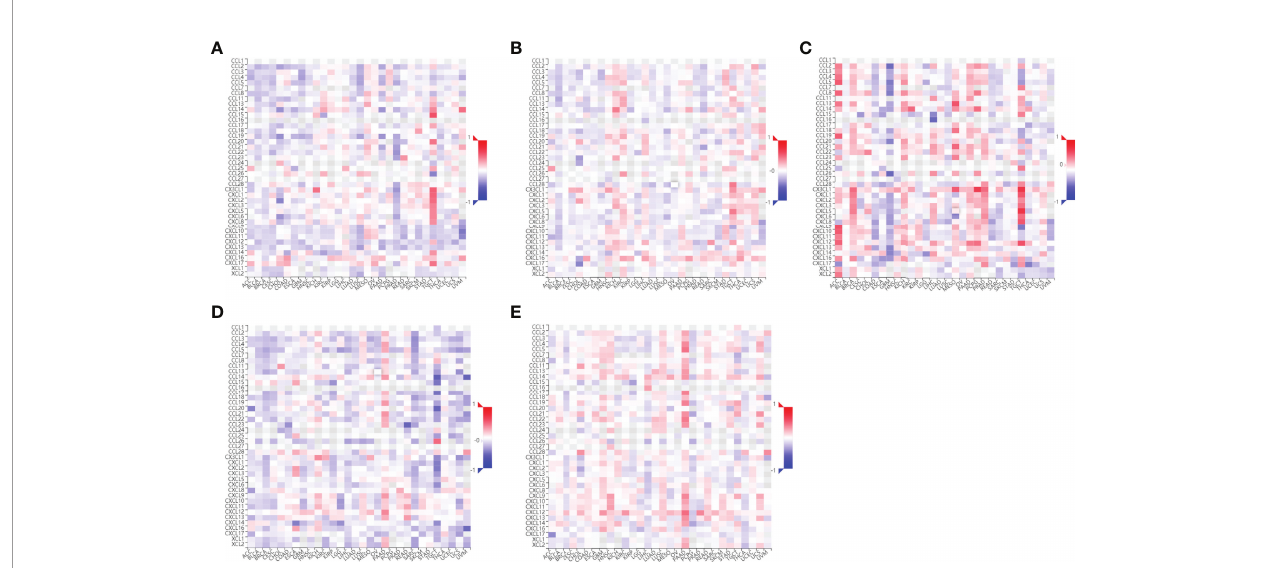
FIGURE 8 | Correlations between chemokines and the 5 core target genes were explored using TISIDB database. (A) AKT1-chemokines. (B) TP53-chemokines. (C) NOTCH1-chemokines. (D) SIRT1-chemokines. (E) PTEN-chemokines.